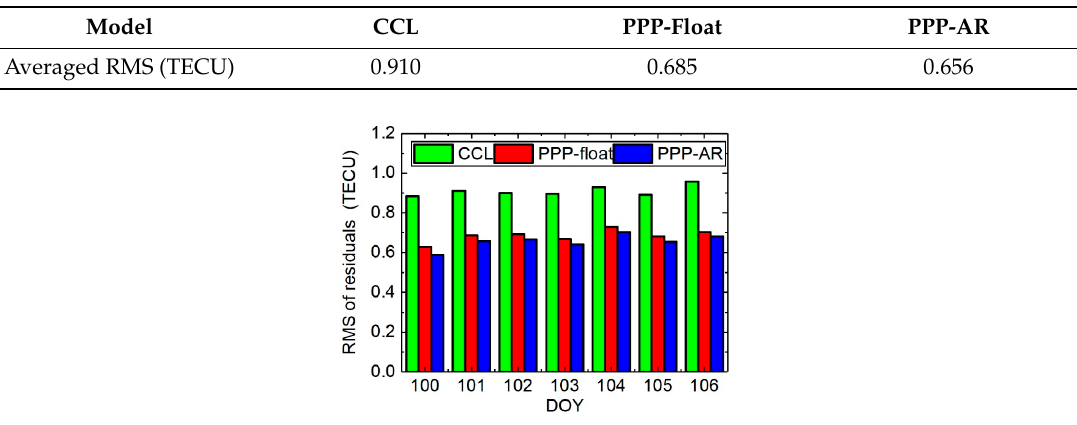
Figure 7. RMS of posteriori residuals for the CCL, PPP-float, and PPP-AR ionospheric observables from DOY 100 to 106, 2017.